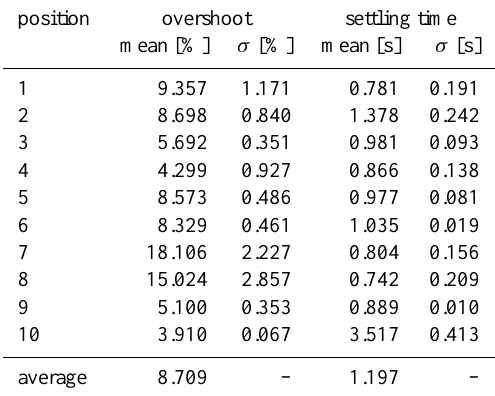
Figure 2. General kinematic parameters